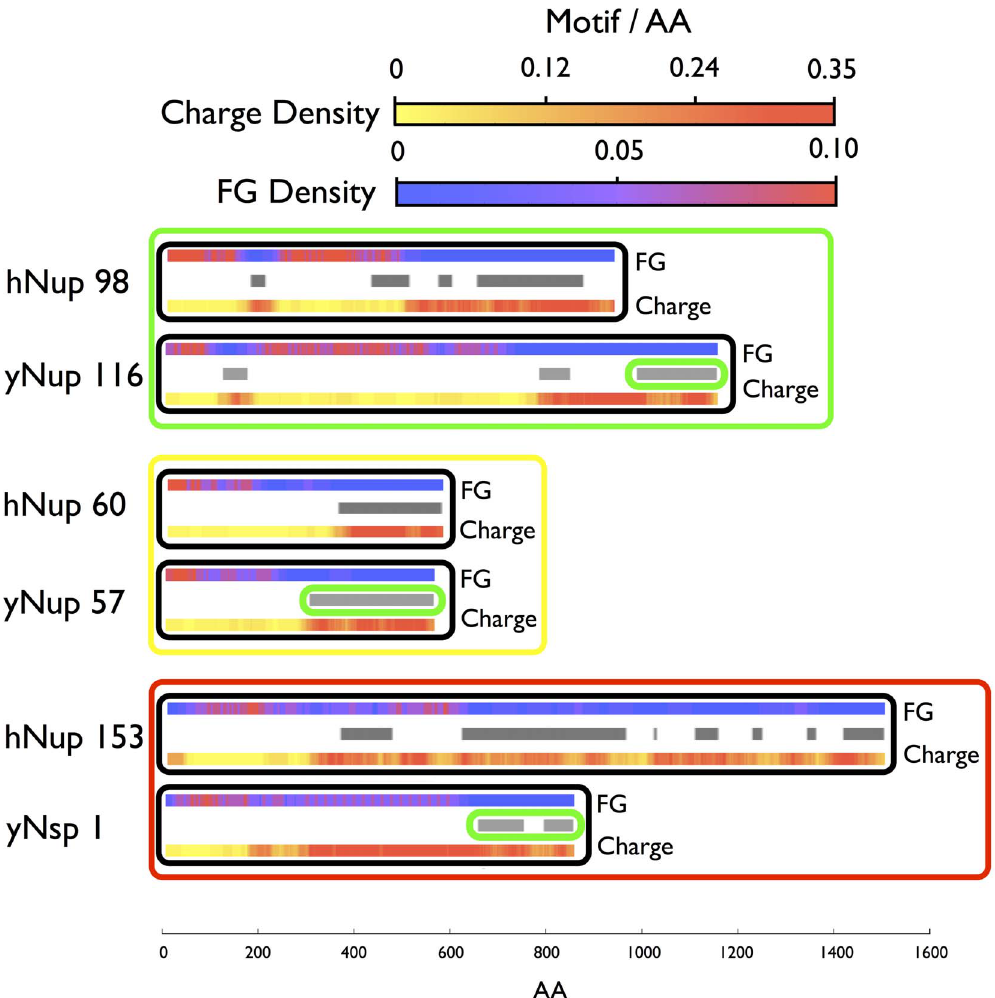
Figure 4. Identification of homologous proteins. Example proteins from S. cerevisiae (‘y’ prefix) and humans (‘h’ prefix) for each functional clustering group. Boxed in green are example proteins with low overlap between FG and charge clusters and a topological complexity of 3. In the yellow box are example proteins with low toplogical complexity and diblock structure, the first clustering group described in the text. Example proteins from the last clustering group described in the text are boxed in red at the bottom, with these proteins displaying high overlap and high levels of topological complexity (Nup153 sequence reversed to ease comparison with Nsp1).